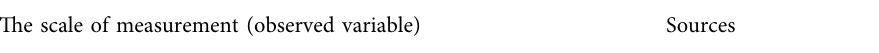
Table 1: Scale of